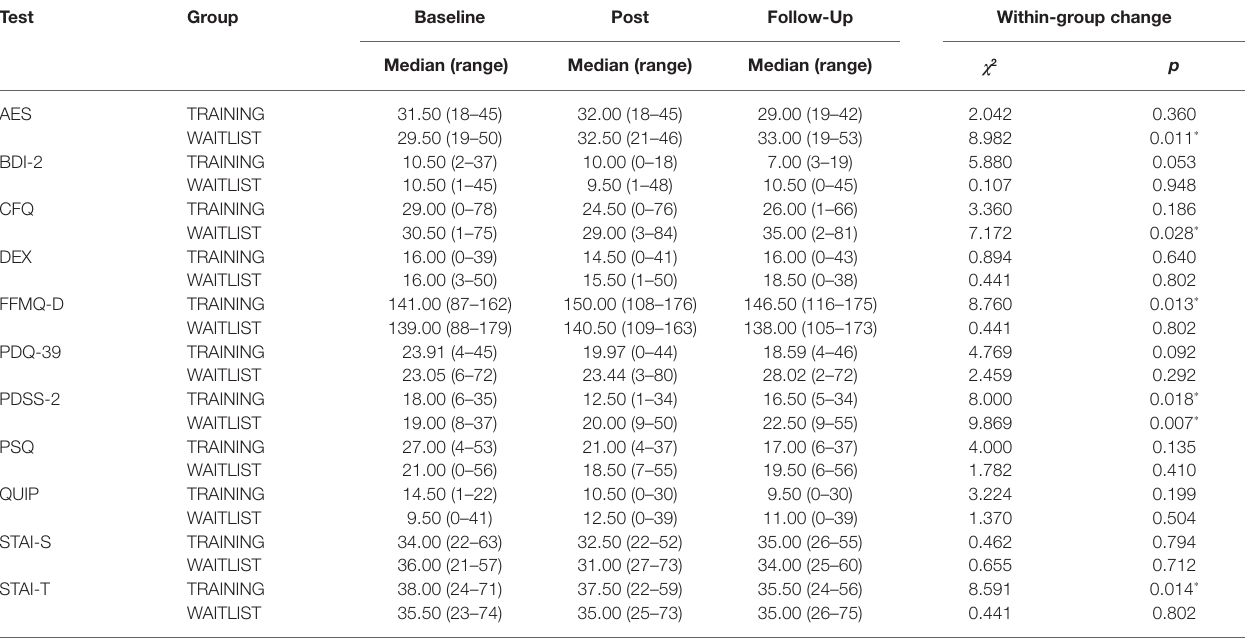
TABLE 7 | Questionnaire total score changes for all measurement